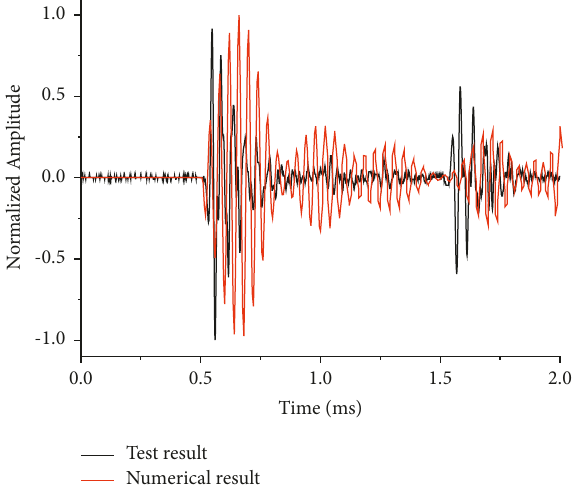
Figure 8: Comparison of numerical and experimental results.